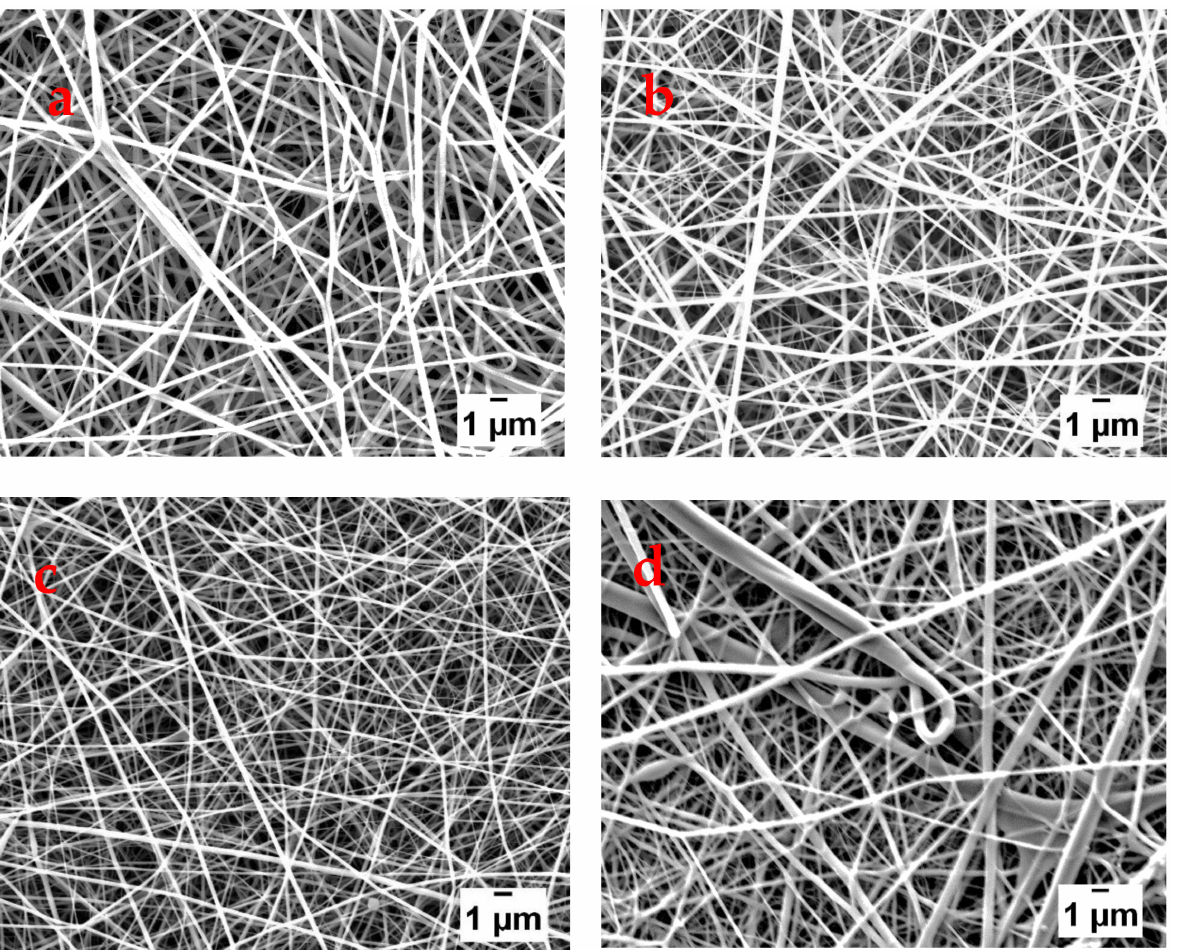
Figure 7. SEM images of nanofibers fabricated using applied voltages of ( a ) 10, ( b ) 13, ( c ) 15, and ( d ) 17